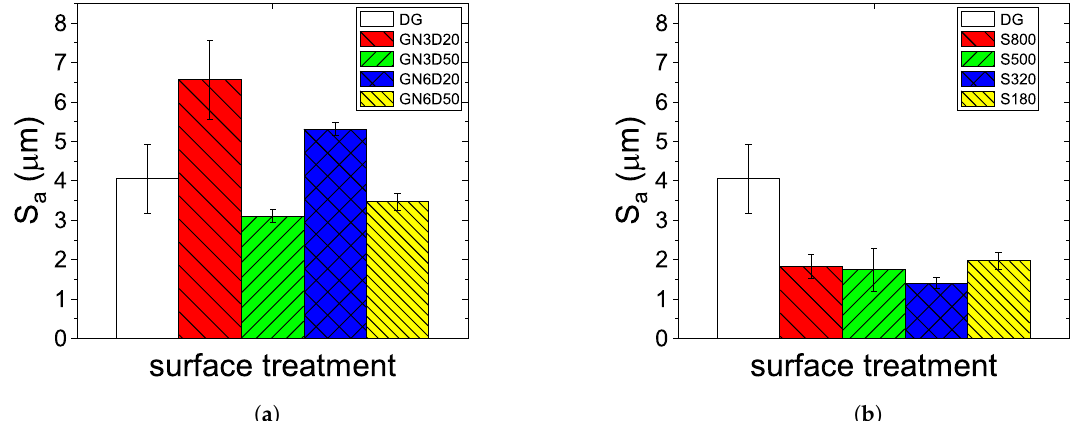
Figure 7. Surface roughness of CFRP plates: ( a ) grit-blasted and ( b ) sanded